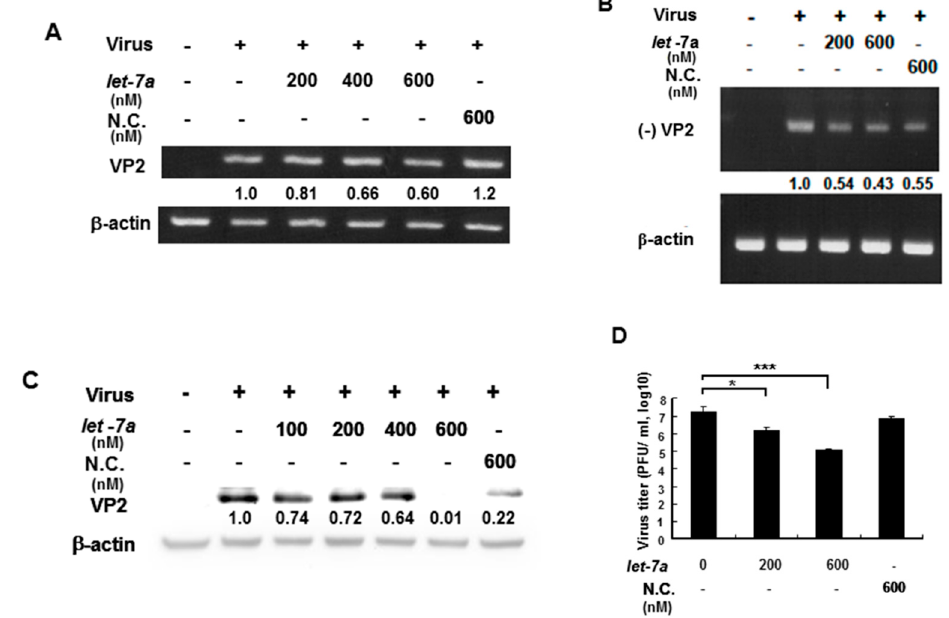
Figure 4. Let-7a suppressed EV71/4643 replication in infected RD cells. RD cells were transformed with let-7a for 24 hr before infection with EV71/4643 (MOI = 10) for 9 hr. ( A ) The suppression of let-7a at various concentrations on the viral RNA expression was evaluated by RT-PCR using the primers against (+) VP2 sequences. NC was the scramble control microRNA. The β -actin gene was used as the control. ( B ) The suppression of let-7a on negative-strand viral RNA expression (designated as ( − ) VP2) was evaluated by RT-PCR using the primers against (-) VP2 sequences. The negative control (NC) was the scramble control microRNA. The β -actin gene was used as the control. ( C ) Let-7a suppression of VP2 protein levels in viral-infected cells was determined by Western blotting using specific antibodies. β -actin was used as the internal control. ( D ) RD cells were transfected with let-7a or NC microRNA at various concentrations for 24 hr followed by infection with EV71/4643 (MOI = 10) for 1 hr. The virus titer was determined by plaque assay. Mean ± SD, *: p < 0.05, ***: p < 0.001.